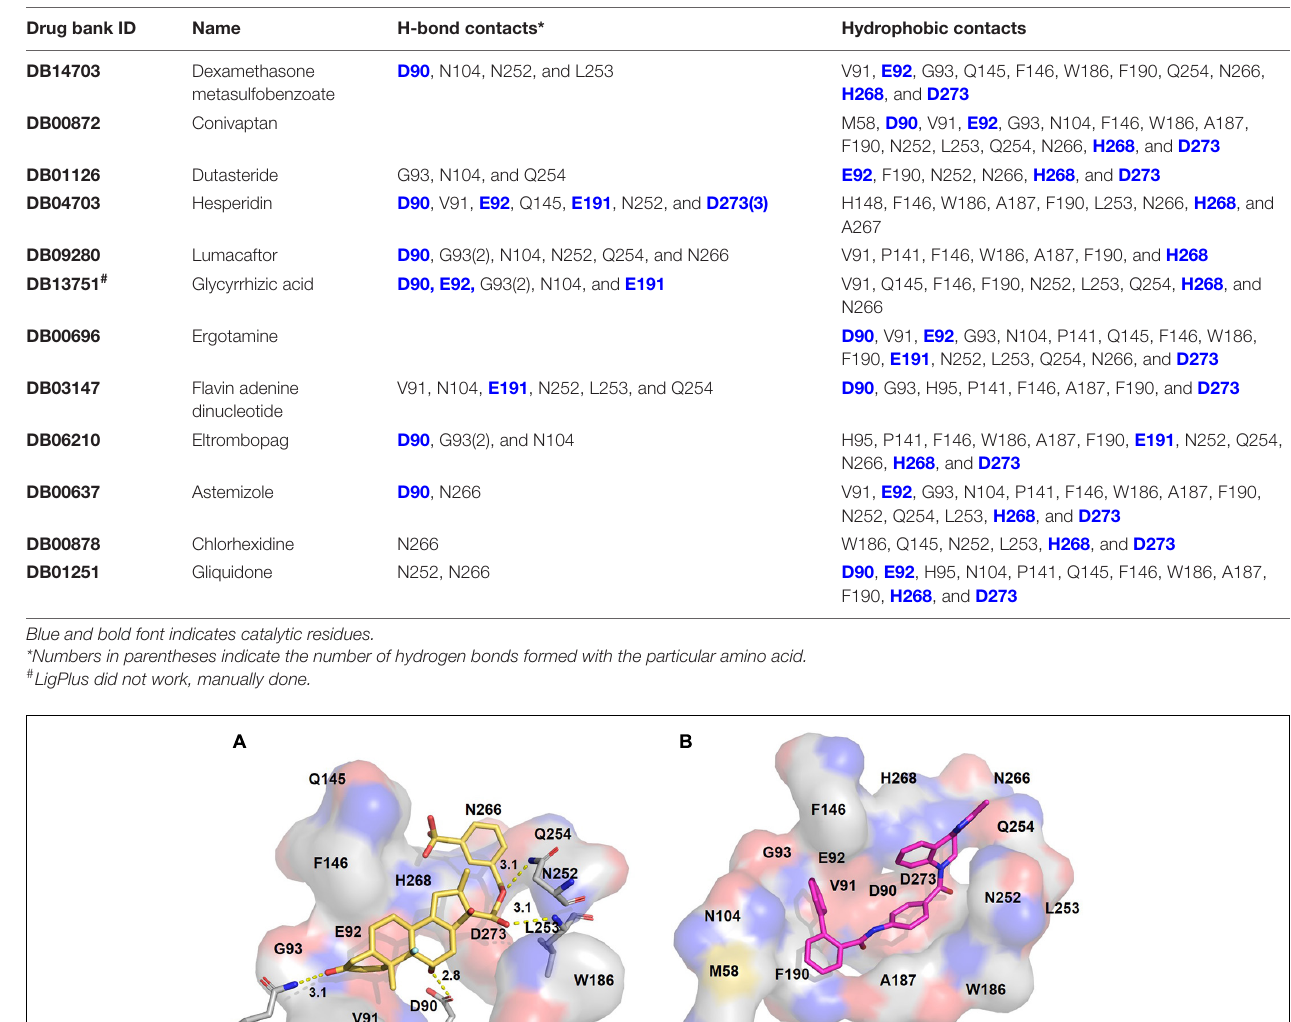
TABLE 2 | Residues involved in hydrogen bond and hydrophobic interaction.